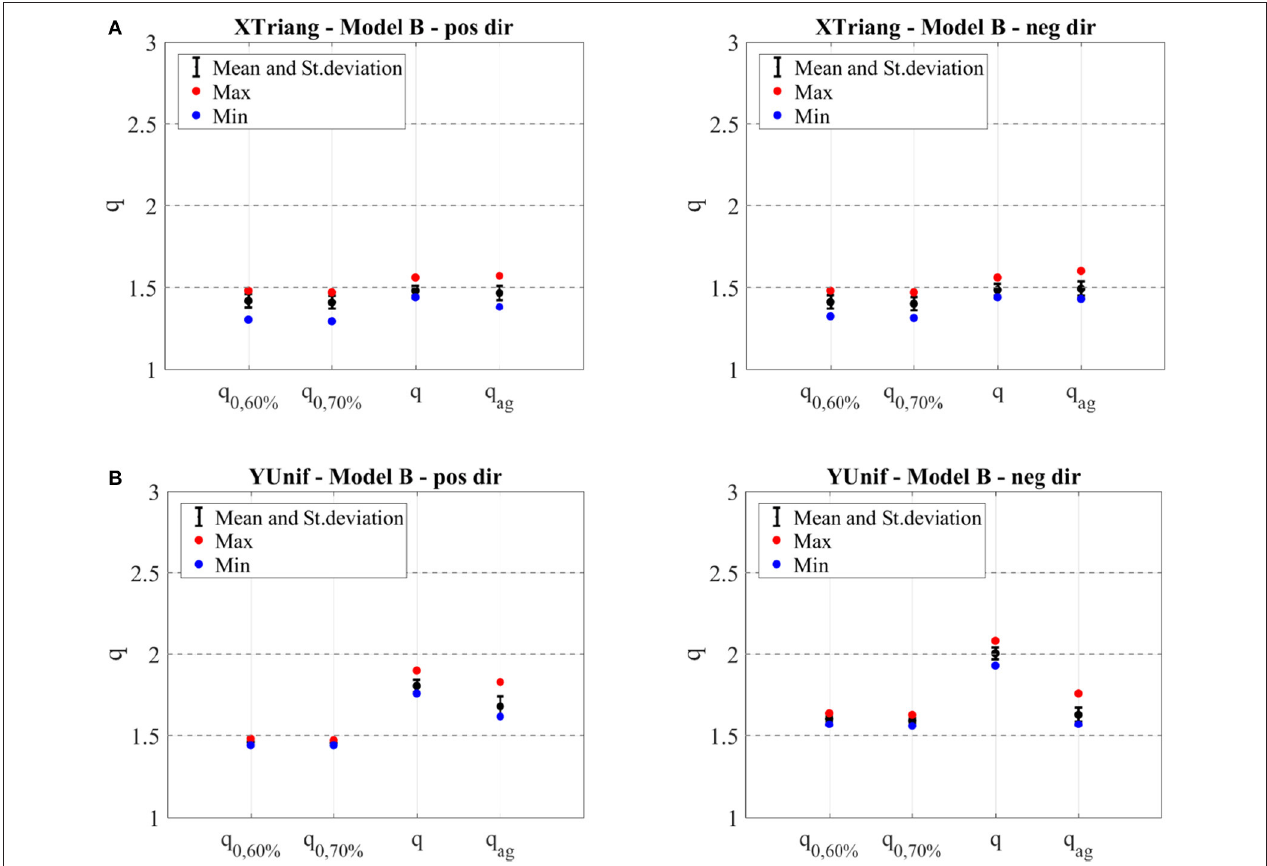
FIGURE 13 | Mean, maximum and minimum values and standard deviation of the behavior factor for X (A) and Y direction (B) for Model B. Doted lines represent the values proposed by NTC Italian Code for Structural Design